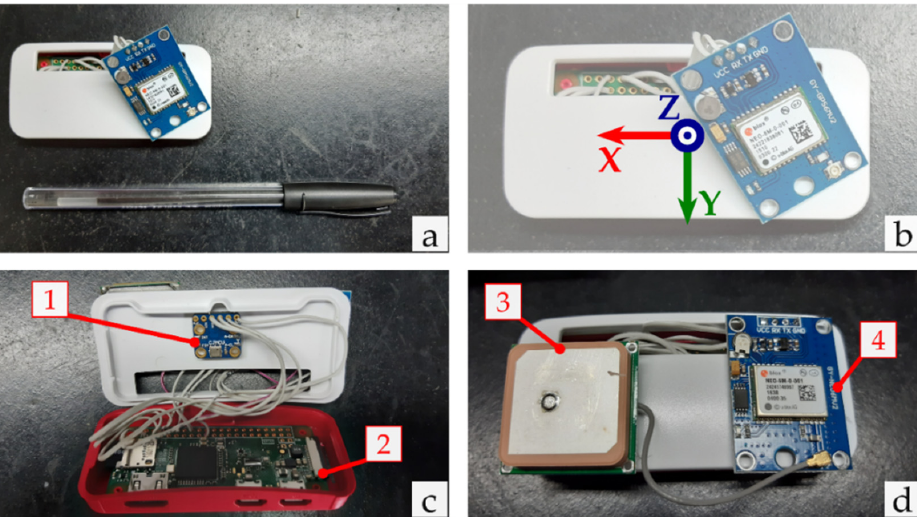
Figure 1. The core components of the developed device: ( a ) size comparison of the Raspberry + IMU module + GPS module assembly; ( b ) sensor axes orientation; ( c ) device with its case open and with a view of the IMU module (1) and the Raspberry Pi Zero W (2); ( d ) closed case with a view of the GPS antenna (3) and the u-Blox GPS module (4).